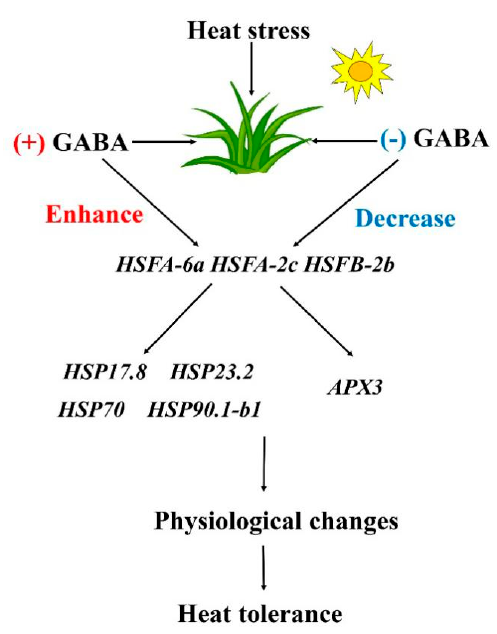
Figure 9. Proposed heat shock factor pathways regulated by γ -aminobutyric acid (GABA) in creeping bentgrass under heat stress.